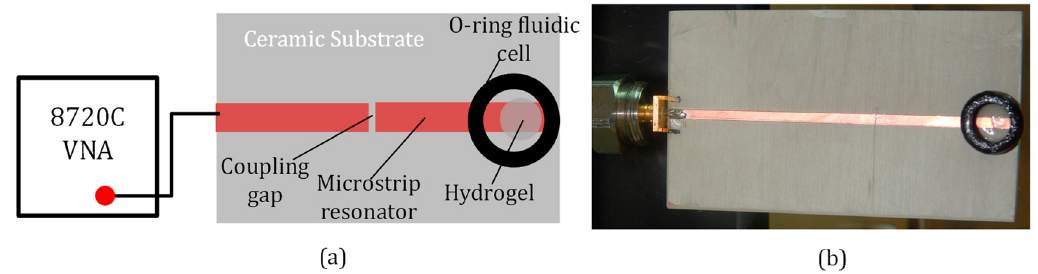
Figure 4. Sensor for monitoring hydrogel response with microwaves in the contact mode. ( a ) Schematic of the sensor. ( b ) Photograph of the sensor.